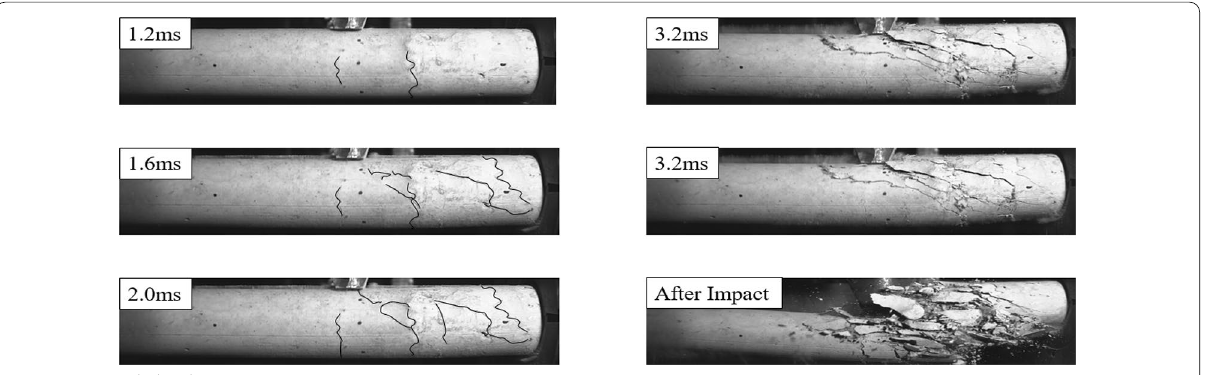
Fig. 8 YH3 crack development process.